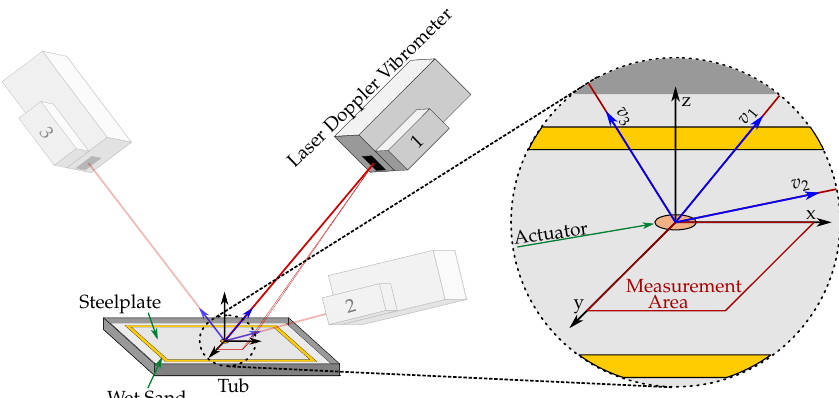
Figure 3. Experimental setup for different laser Doppler velocimeter (LDV) positions (1–3), with global Cartesian in-plane coordinate system N ( x , y , z ), local oblique measurement coordinate system K ( v 1 , v 2 , v 3 ), and measurement area